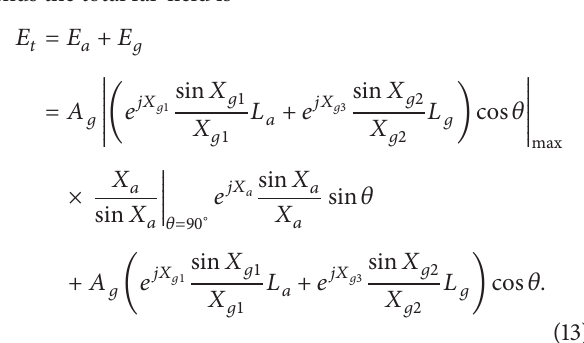
Table 1: Parameter for monopole Yagi-Uda